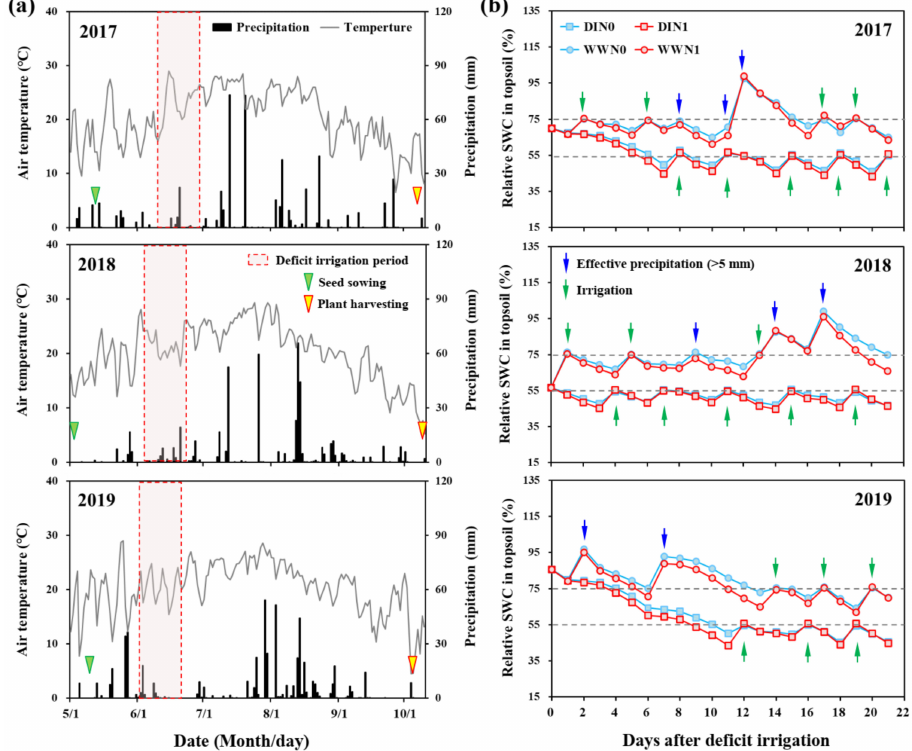
Figure 7. Daily precipitation (bars) and average air temperature (line) throughout the entire maize growing season ( a ) and dynamic of relative soil water content (SWC) in topsoil (0–20 cm) during the seedling-stage deficit irrigation periods ( b ) in 2017–2019 at Lishu county, Northeast